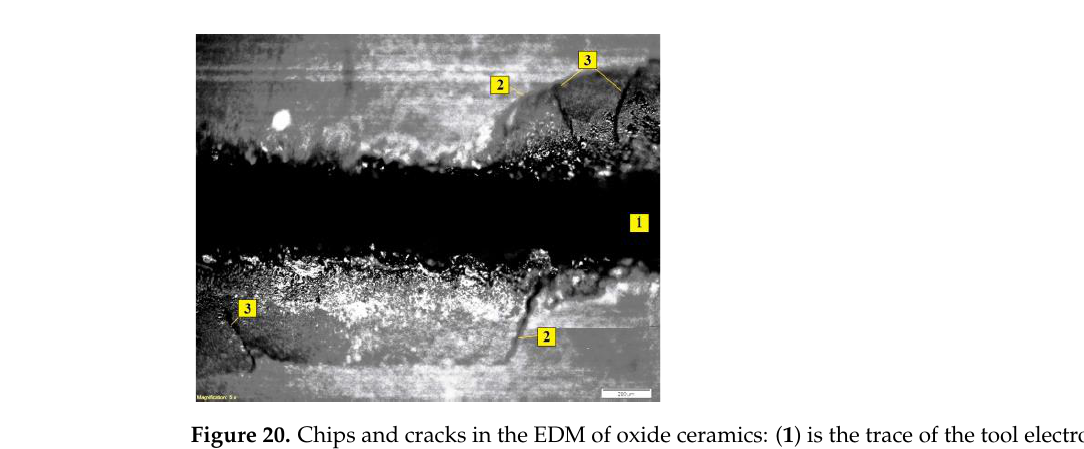
Figure 19. Examples of calculating temperature fields by the finite element method during the normal course of the EDM ( a ) and during the localization of discharges ( b ), where ( 1 ) is the tool electrode; ( 2 ) is the workpiece electrode.